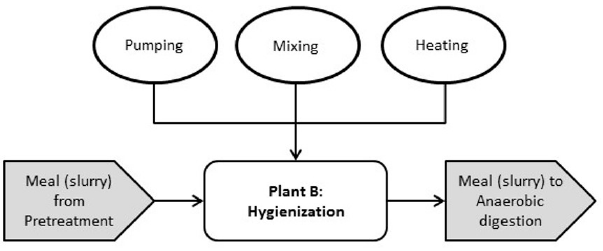
Figure 5. The connection between the sub-process hygienization and unit processes at biogas plant B.